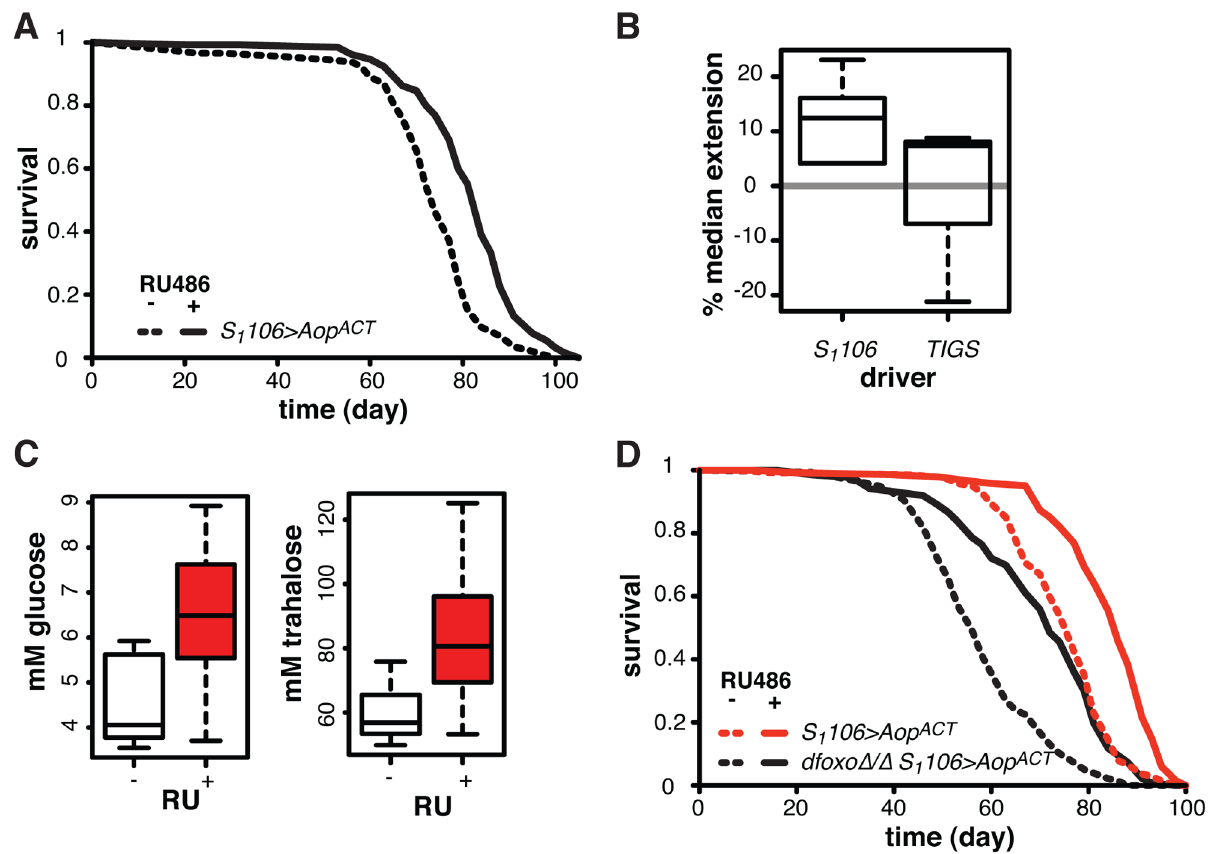
Figure 7. Aop extends lifespan. A Survival of S 1 106 . Aop ACT female flies in the presence or absence or RU486. Log-rank test detected significant differences (p=2 6 10 2 10 ; total dead/censored: 2 RU486 145/1, + RU486 129/3; median/maximum lifespan: 2 RU486: 74/87, + RU486 84/97). B Median lifespan extension achieved by RU486 feeding in S 1 106 . Aop ACT (6 experiments) or TIGS . Aop ACT (3 experiments) females. Log-rank test detected significant extension (p , 0.05) of lifespan in 6 out of 6 S 1 106 . Aop ACT and in 1 out of 3 TIGS . Aop ACT trials. In one TIGS . Aop ACT trial lifespan was shortened. C Haemolymph glucose and trehalose in S 1 106 . Aop ACT females fed or not RU486, where RU486 had a significant effect in each case (t-test, p=0.01 and 0.02 respectively; n=8 where 10 measurements were made and the highest and lowest measurement removed from each group). D Survival of S 1 106 . Aop ACT or dfoxo D / D S 1 106 . Aop ACT female flies in the presence or absence or RU486. Log-rank test detected significant differences for both: